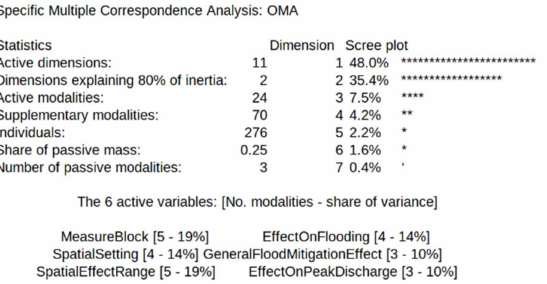
Figure A3. MCA model of Other Mountain Areas (sub-data set 3).